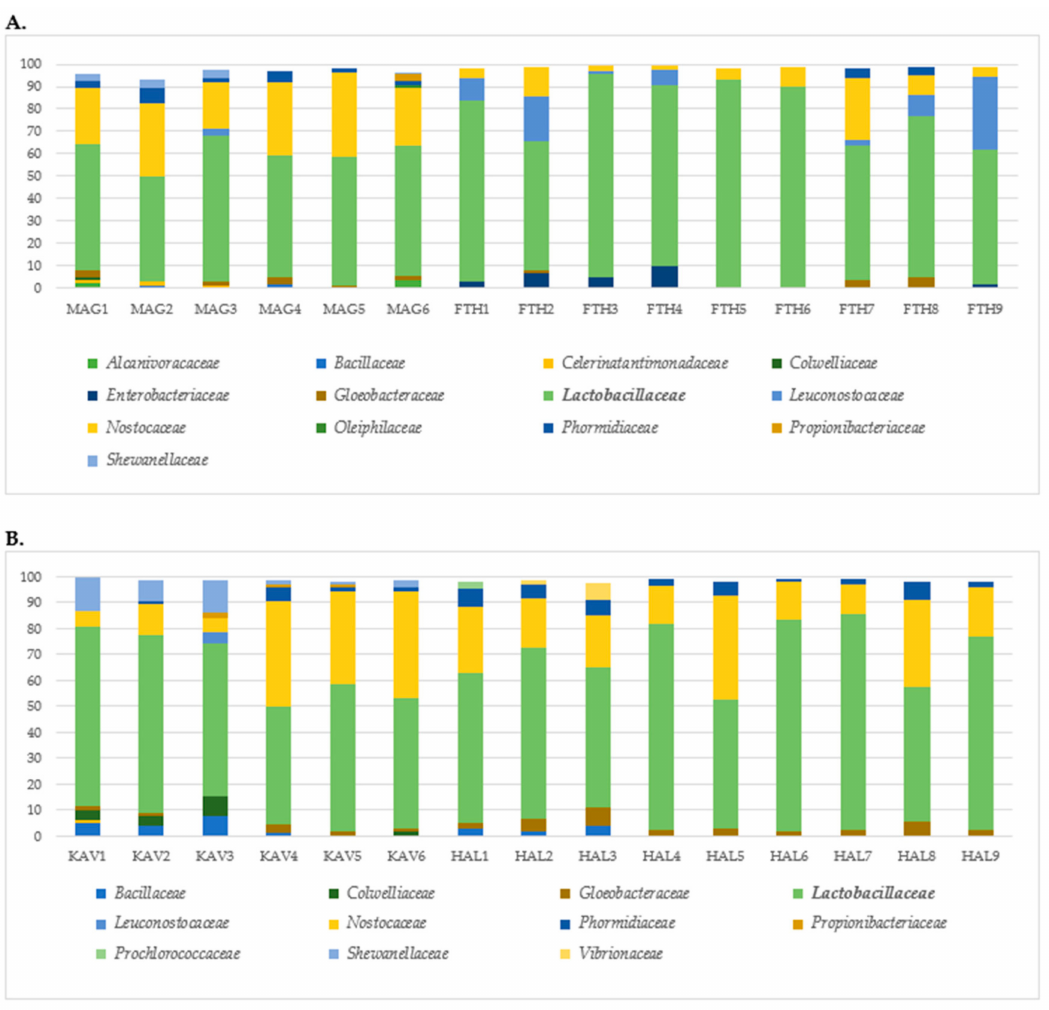
Figure 4. Relative abundance of total observed bacterial families on table olives of ( A ) cv. Konservolia originating from the regions of Magnesia (MAG) and Fthiotida (FTH) and ( B ) cv. Halkidiki originating from the regions of Kavala (KAV) and Halkidiki (HAL). Only families above 1% occurrence are